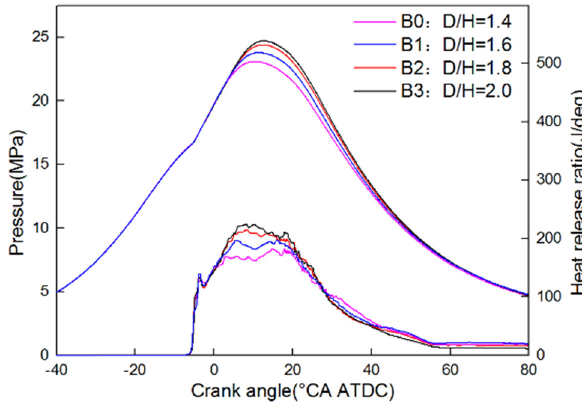
Figure 13: Soot and NOx emissions under di ff erent piston bowls.